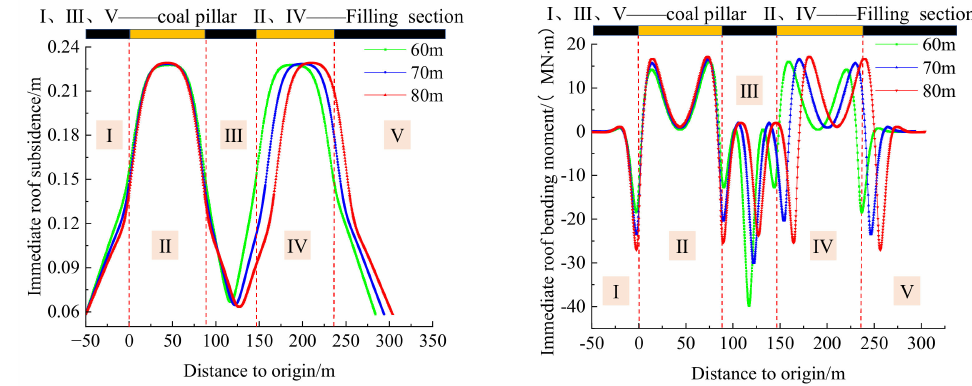
Figure 9. Relationship among the coal-pillar lengths, roof subsidence, and bending